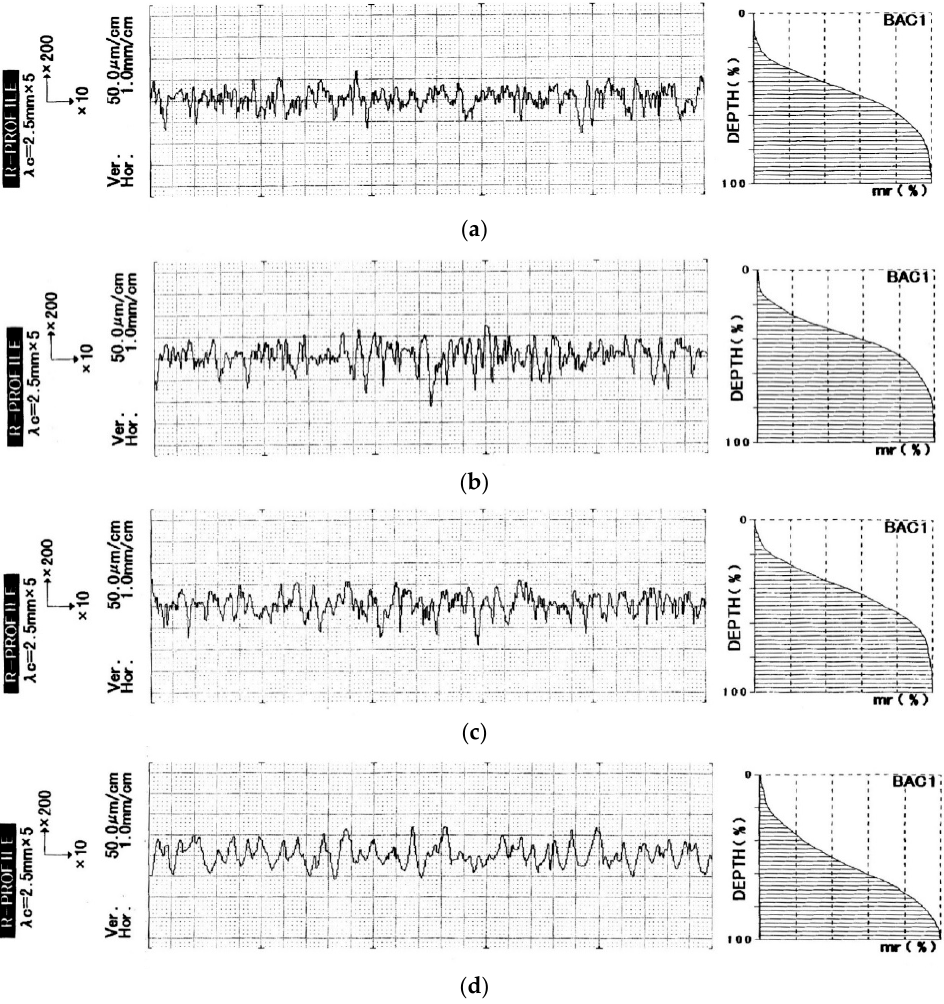
Figure 5. Profilographs and Abbot—Fireston curves blasting surfaces ( a ) SG, ( b ) C, ( c ) DSS, ( d ) SS.